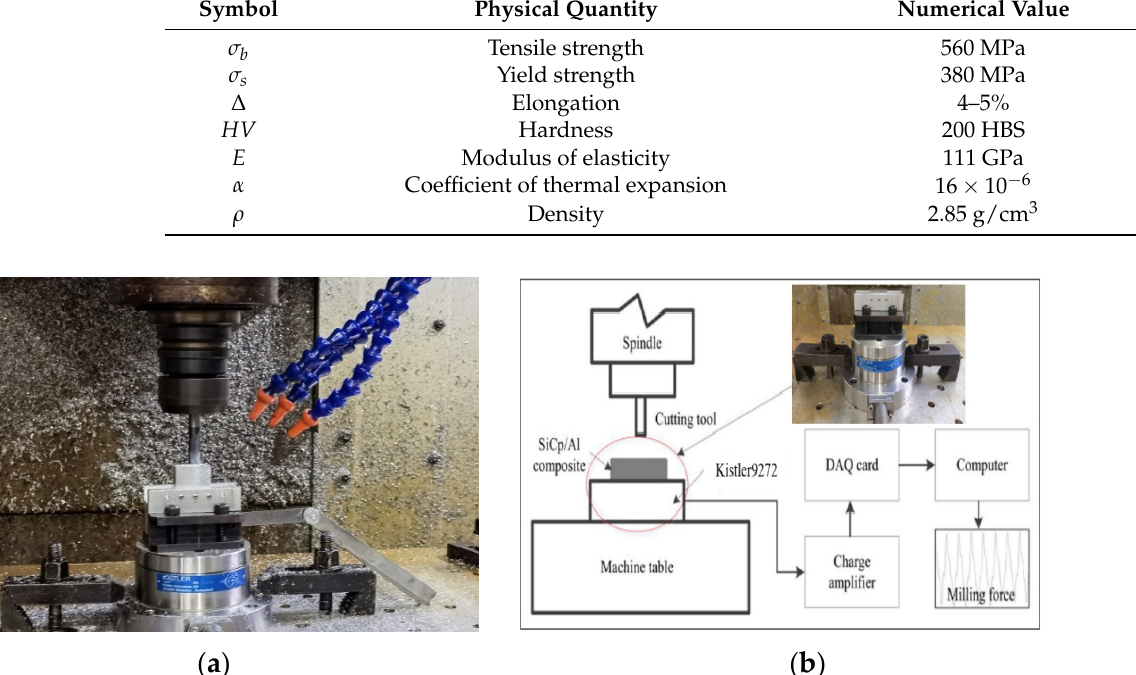
Figure 1. Milling site map and force measuring system ( a ) Milling experimental processing site map ( b ) Milling force measurement system diagram. Table 2. Geometric parameters and mechanical properties of cutting tools. Modulus of Elasticity Material